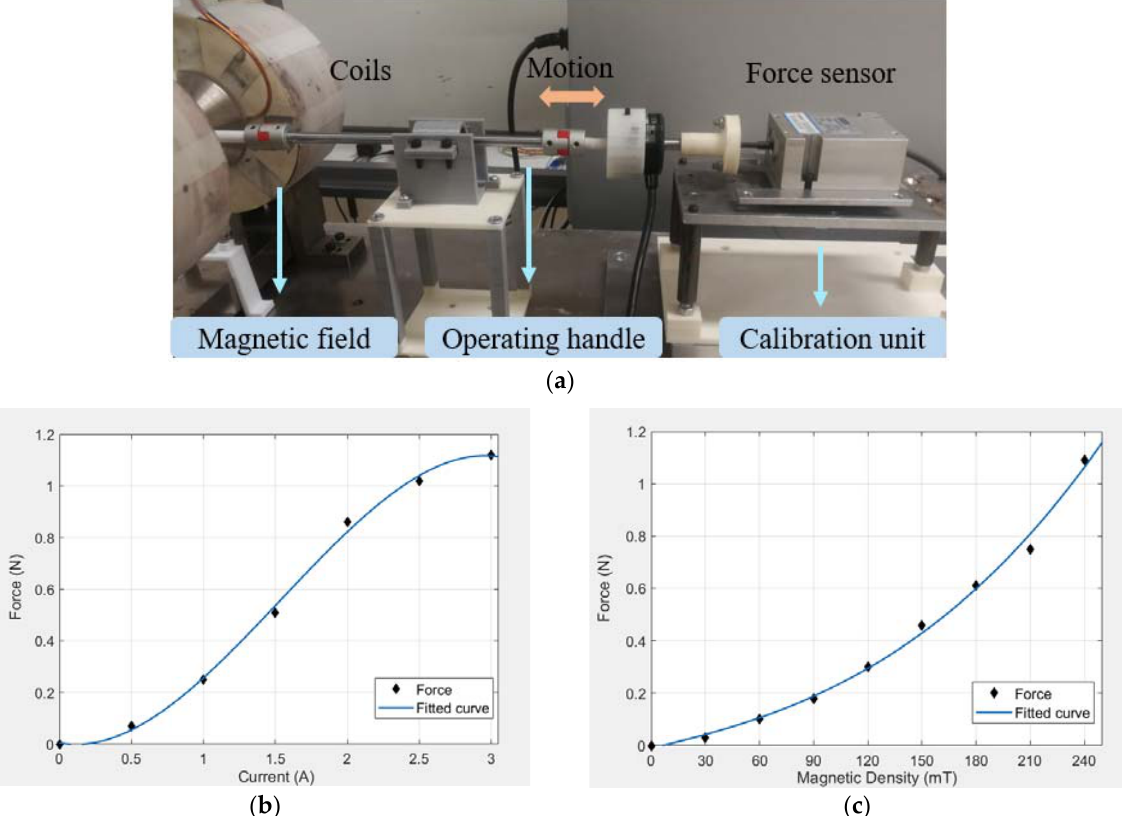
Figure 11. Calibration Experiment and results for the proposed haptic force feedback: ( a ) calibration experimental set ‐ up; ( b ) relationship between supplied current and haptic force; ( c ) relationship between supplied magnetic density and haptic force.